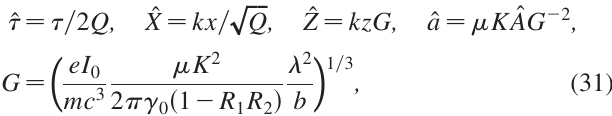
FIG. 7. Formation of the transverse (over x axis) field structure in the process of establishment of the steady-state regime ( 7 3 , ^(cid:2) ¼ (cid:2) 0 : 5 , ^ L 0 ¼